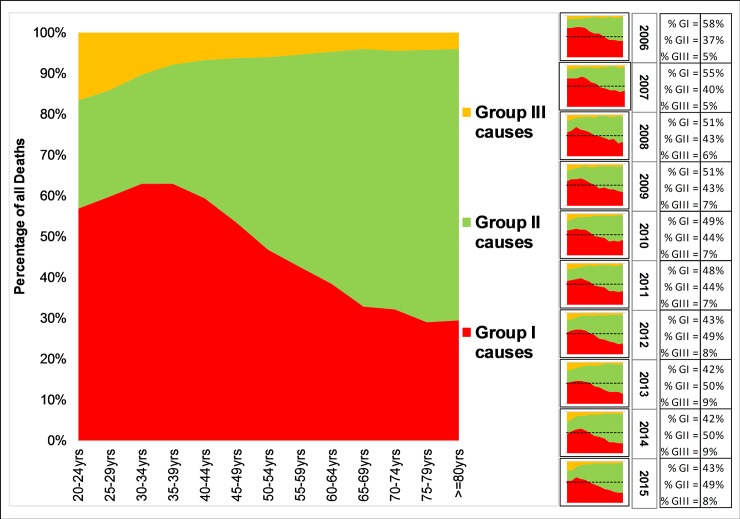
Distribution of death by the three Global Burden of diseases categories, 2006–2015.The overall contribution from young adults to old age for the entire study period is GI = 46.67; GII = 46.06 and GIII = 7.3. The annual pattern for the same age range is demonstrated on the right side of the plot, the black dotted line indicates the margin on 50% (GI: Group I; GII: Group II; GIII: Group III).